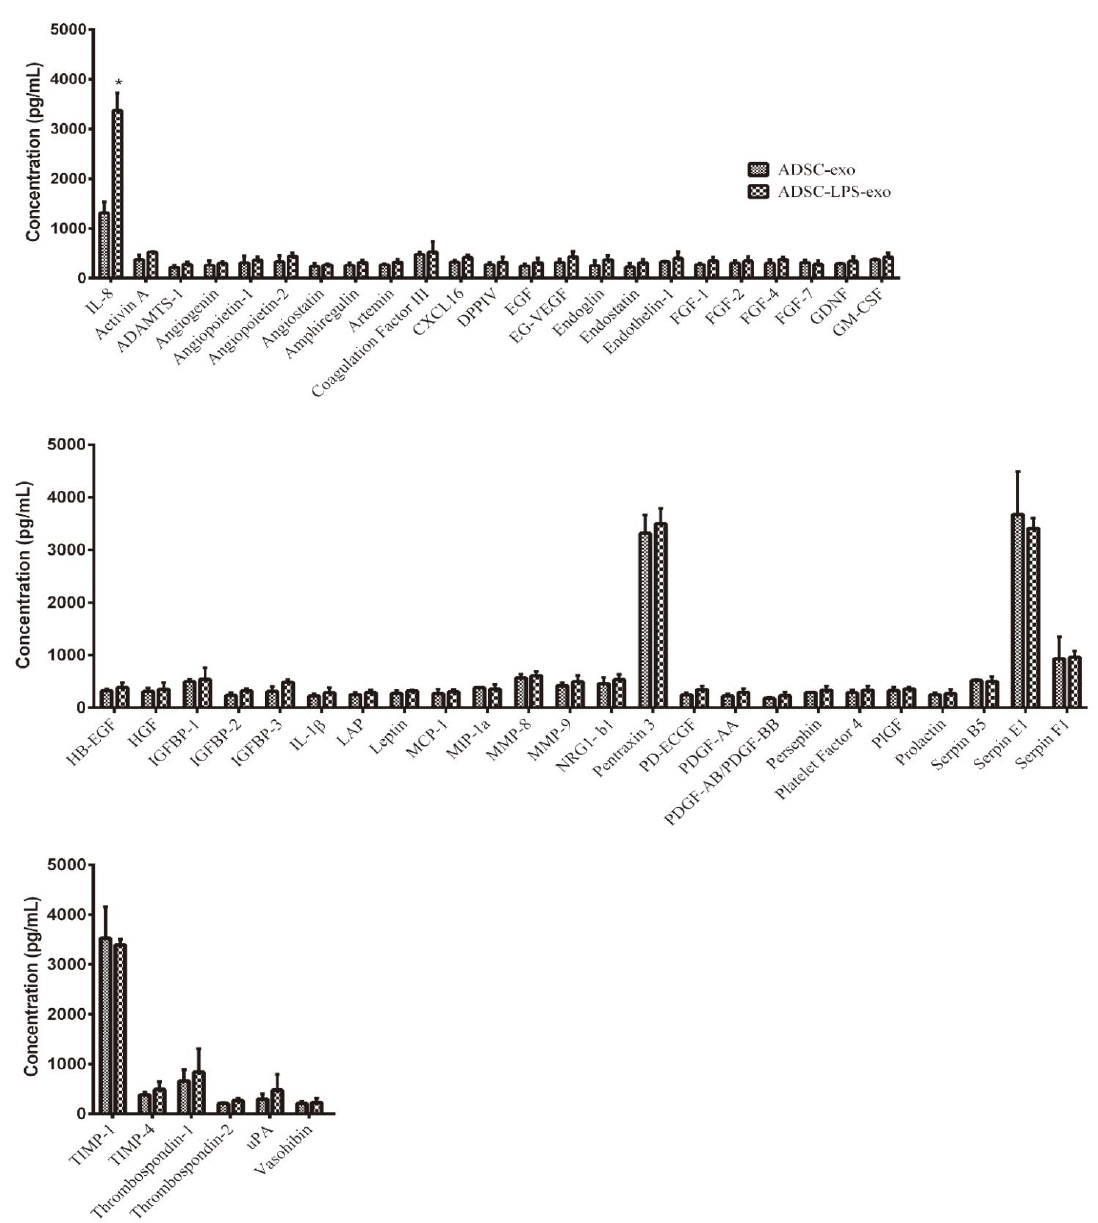
Figure 7. Relative expression of angiogenesis-related proteins in the cell lysates of HUVECs following treatment with 30 µg ADSC-LPS-exo or ADSC-exo was detected in quadruplicates using The Proteome Profiler Human Angiogenesis Antibody Array, which can detect 25 human angiogenesis-related proteins simultaneously with chemiluminescent detection reagents (*, a p -value < 0.05 with at least a 2-fold difference).